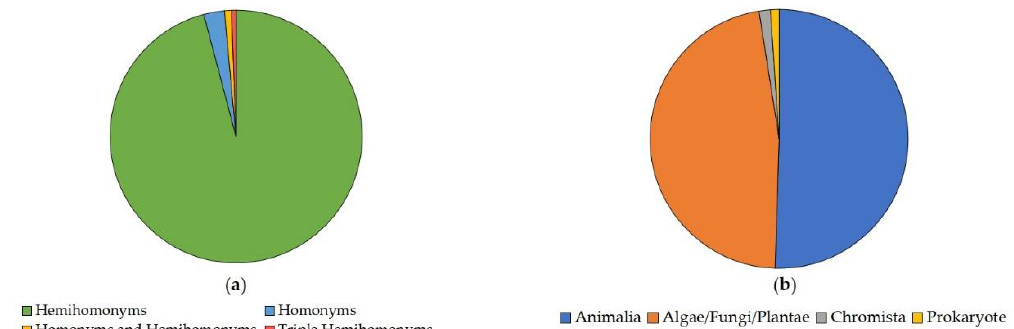
Figure 1. ( a ) Proportions of hemihomonyms (95.88%) in green, homonyms (2.65%) in blue, hemi- and homonyms (0.91%) in yellow, and triple hemihomonyms (0.56%) in red; ( b ) There are 2887 nomina that are hemi- and homonyms, 1458 (50.50%) belong to Kingdom of Animalia, 1357 (47%) to the Kingdoms of Algae, Fungi, or Plantae, 41 (1.42%) to the Kingdom of Chromista, and 31 (1.07%) to the Kingdom of Prokaryote.